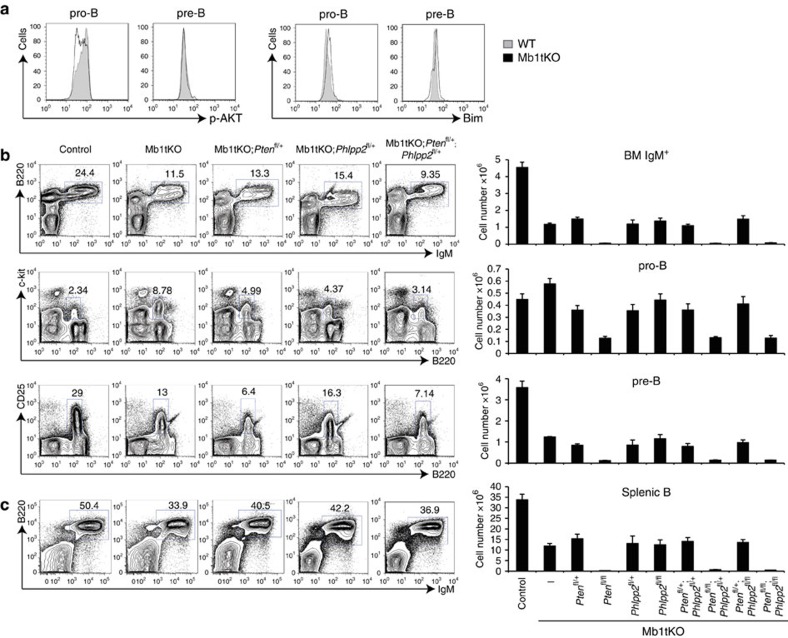
Ablation of Pten and Phlpp2 do not rescue early B-cell development in mice deficient of the miR-17∼92 miRNA family.(a) Phospho-Akt T308 (p-AKT) and Bim protein levels were measured in pro-B and pre-B cells of control and Mb1tKO mice by flow cytometry and presented as overlay histograms. (b) Representative flow cytometry plots and cell numbers of IgM+ B cells (B220+IgM+), pro-B cells (B220intckit+) and pre-B cells (B220intCD25+) in the bone marrow of mice of indicated genotypes. (c) Representative flow cytometry plots and cell numbers of splenic IgM+ B cells (B220+IgM+) in mice of indicated genotypes. Data are representative of 2 (a) or 8 (b,c), or pooled from 8 (b,c) independent experiments (mean±s.e.m. in b,c) with n=4 (a: Phospho-Akt(T308)) or 2 (a: Bim) in a, n=5 (Control, Mb1tKO, Mb1tKO;Ptenfl/+Phlpp2fl/+ and Mb1tKO;Ptenfl/+Phlpp2fl/fl), 7 (Mb1tKO;Ptenfl/fl), 9 (Mb1tKO;Ptenfl/+), 8 (Mb1tKO;Phlpp2fl/fl), 6 (Mb1tKO;Phlpp2fl/+ and Mb1tKO;Ptenfl/flPhlpp2fl/+) or 3 (Mb1tKO;Ptenfl/flPhlpp2fl/fl) in b (BM Ig+ and preB) and c, and n=4 (Control and Mb1tKO), 5 (Mb1tKO;Ptenfl/fl, Mb1tKO;Ptenfl/+Phlpp2fl/+, Mb1tKO;Ptenfl/+Phlpp2fl/fl and Mb1tKO;Ptenfl/flPhlpp2fl/+), 9 (Mb1tKO;Ptenfl/+), 6 (Mb1tKO;Phlpp2fl/fl and Mb1tKO;Phlpp2fl/+) or 3 (Mb1tKO;Ptenfl/flPhlpp2fl/fl) in b (proB).